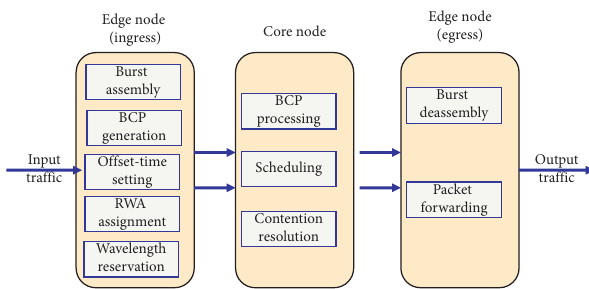
Figure 1: OBS backbone network [1].